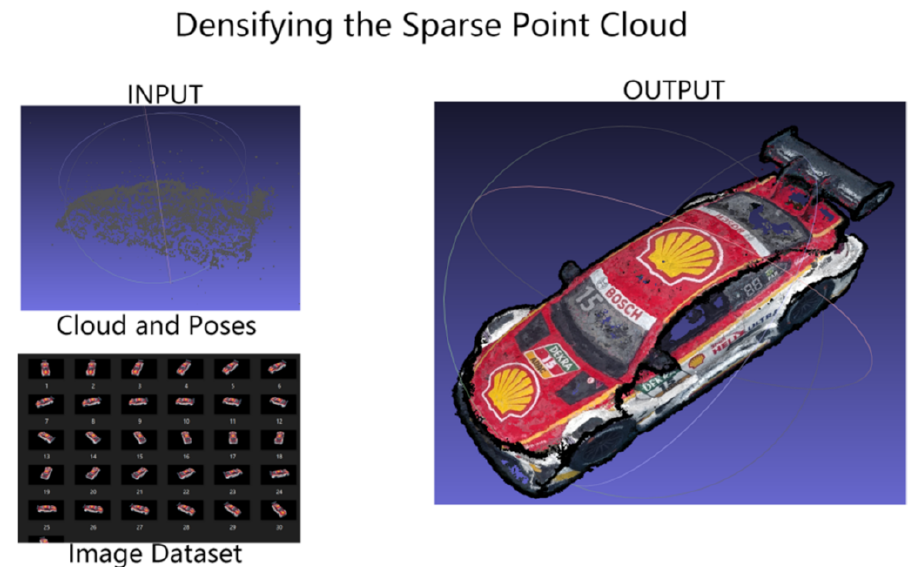
Figure 12. The output of densifying the sparse point cloud by MVS.